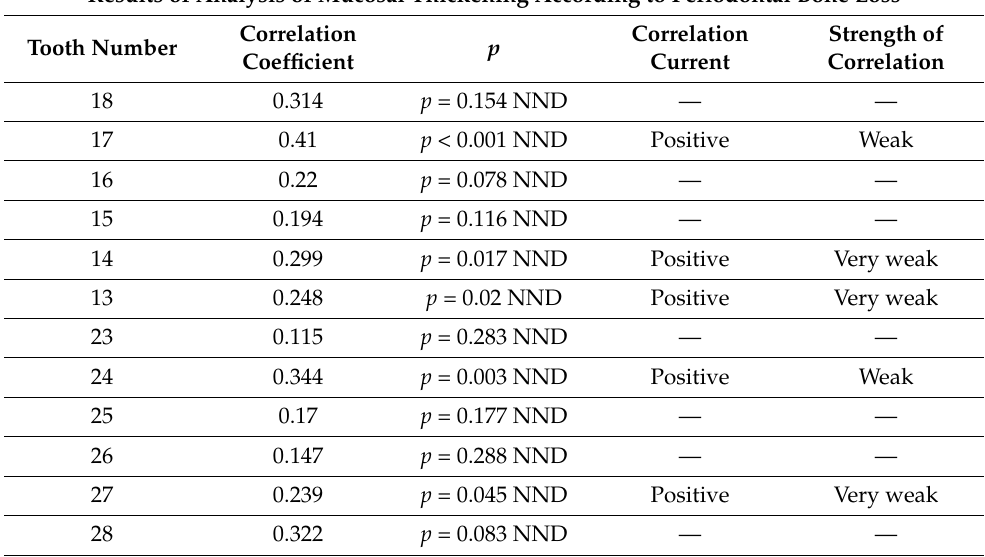
Table 3. Comparison analysis of mucosal thickening according to periodontal bone